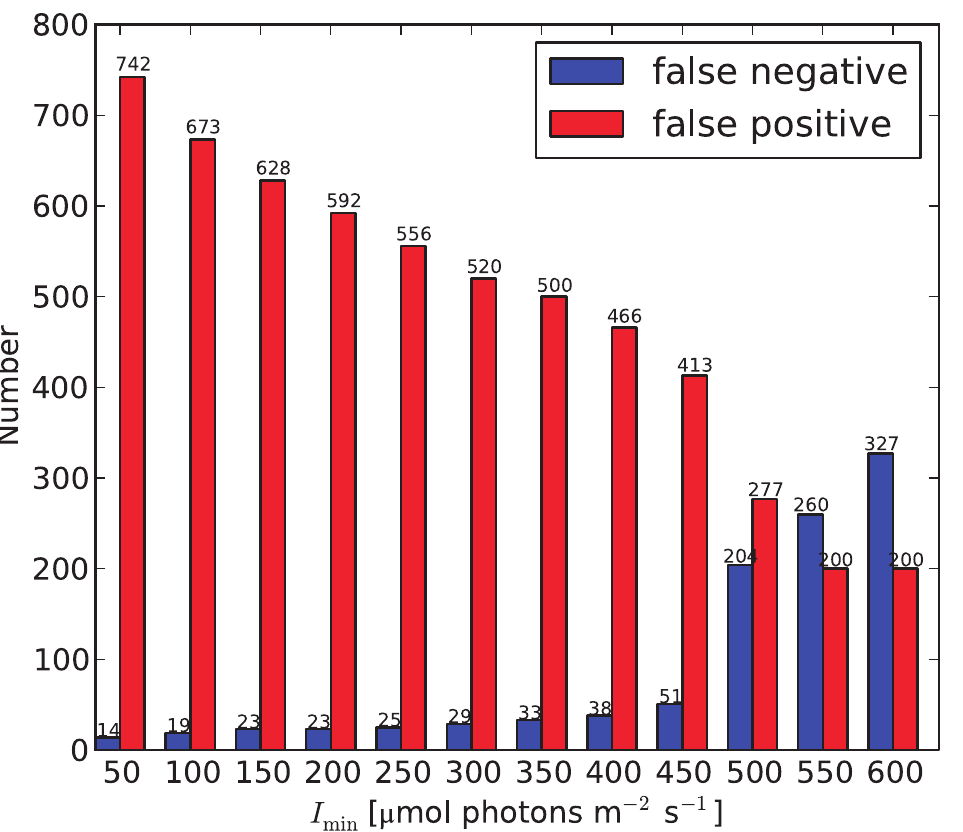
Fig 3. Number of false negatives and false positives obtained at different I min values. False negatives and false positives steadily increase and decrease, respectively. A sharp shift in both false negatives and false positives is observed at I min = 450 μ mol photons m -2 s -1 .